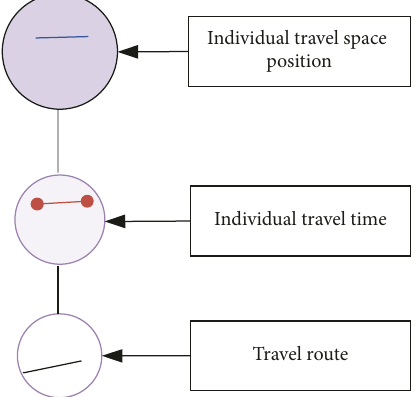
Figure 5: Example of one travel association map of